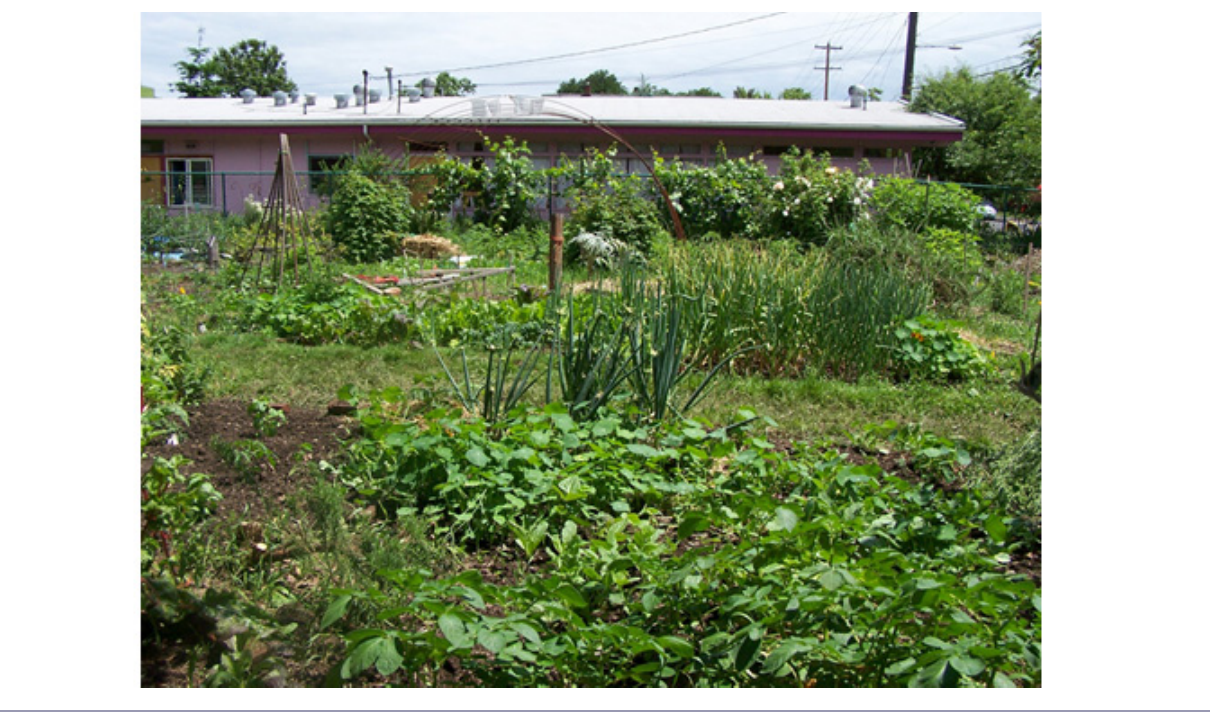
Figure 2. Community garden for the production of food and